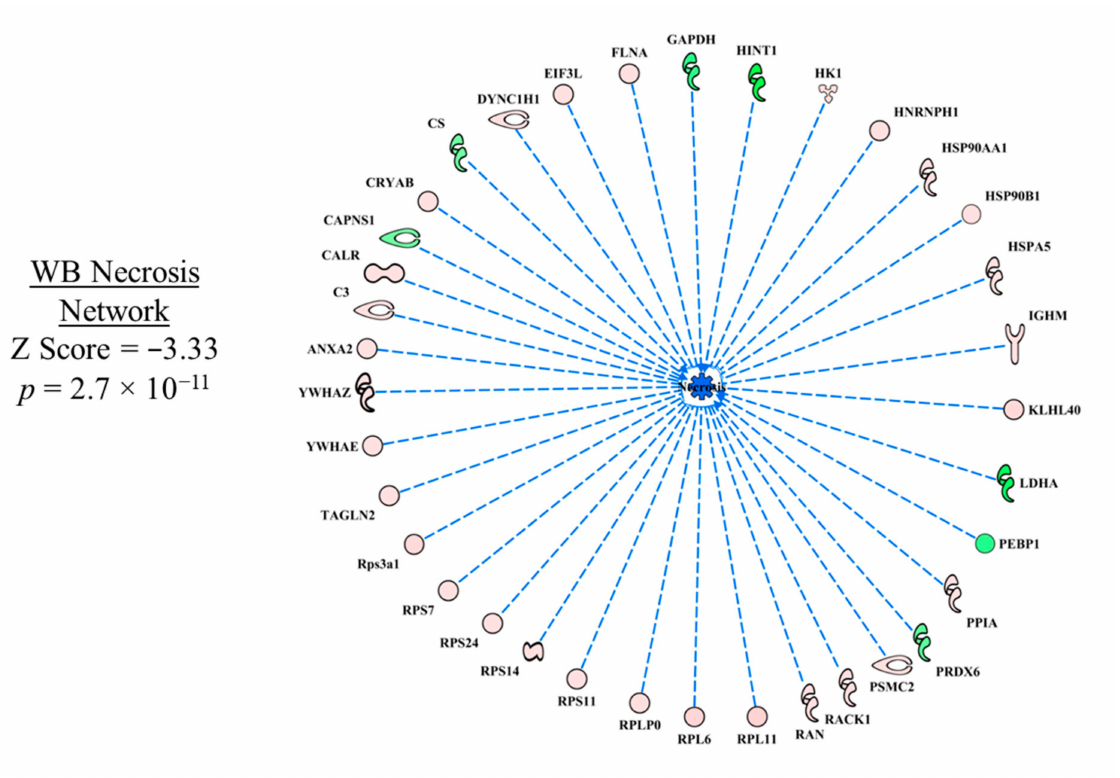
Figure 3. The network of differentially expressed proteins that was used to predict inhibition of necrosis in wooden breast (WB) myopathy. Protein abbreviations are defined and differential expression of proteins are provided in Supplementary Table